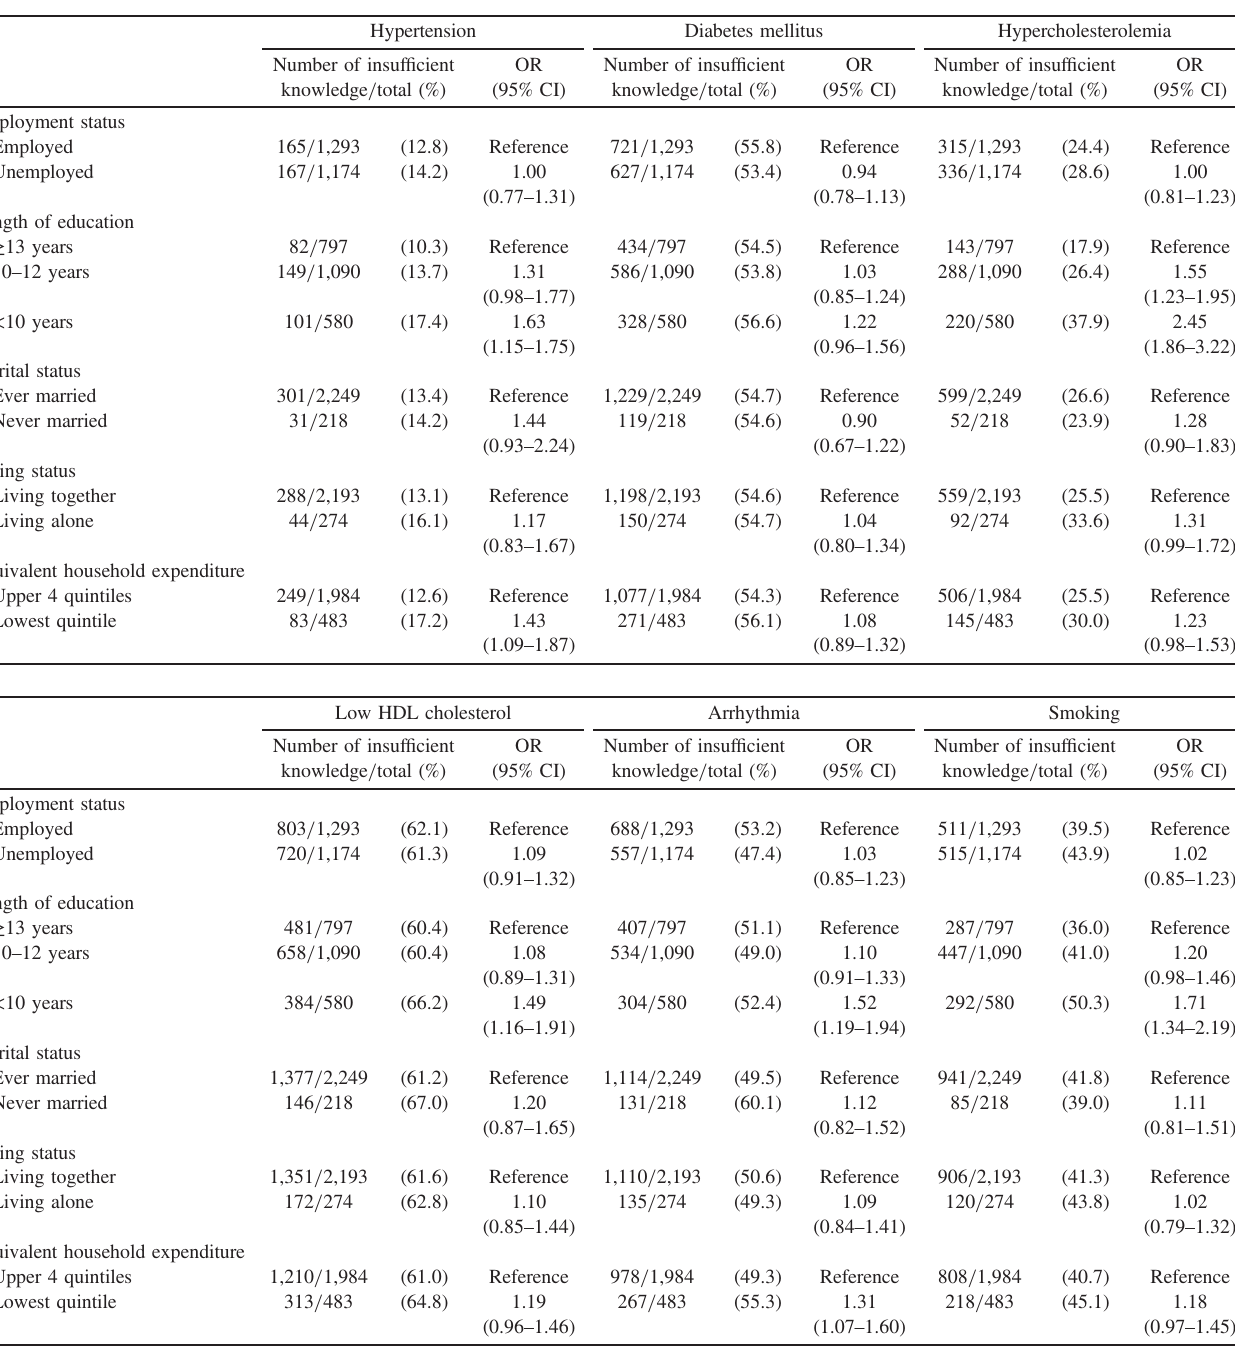
Table 2. Frequency and age- and sex-adjusted odds ratios for insu ffi cient knowledge on each cardiovascular risk factor: NIPPON